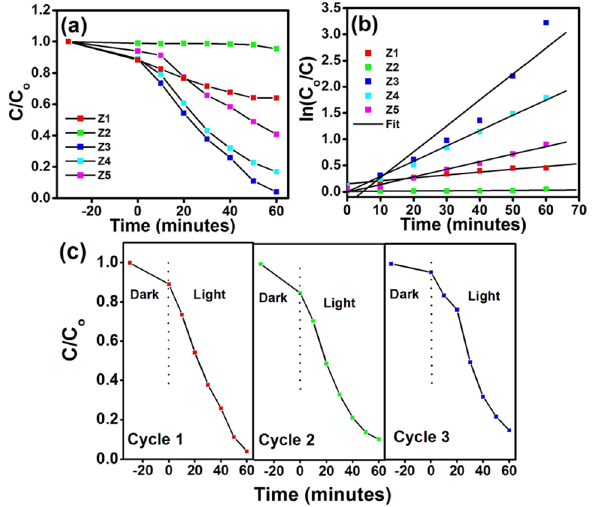
Fig. 8 a Comparison, b kinetics of Photo-degradation of methyl orange under light illumination containing different photocata- lyst and c recyclability test of Z3 for the degradation of MO up to 3 cycles